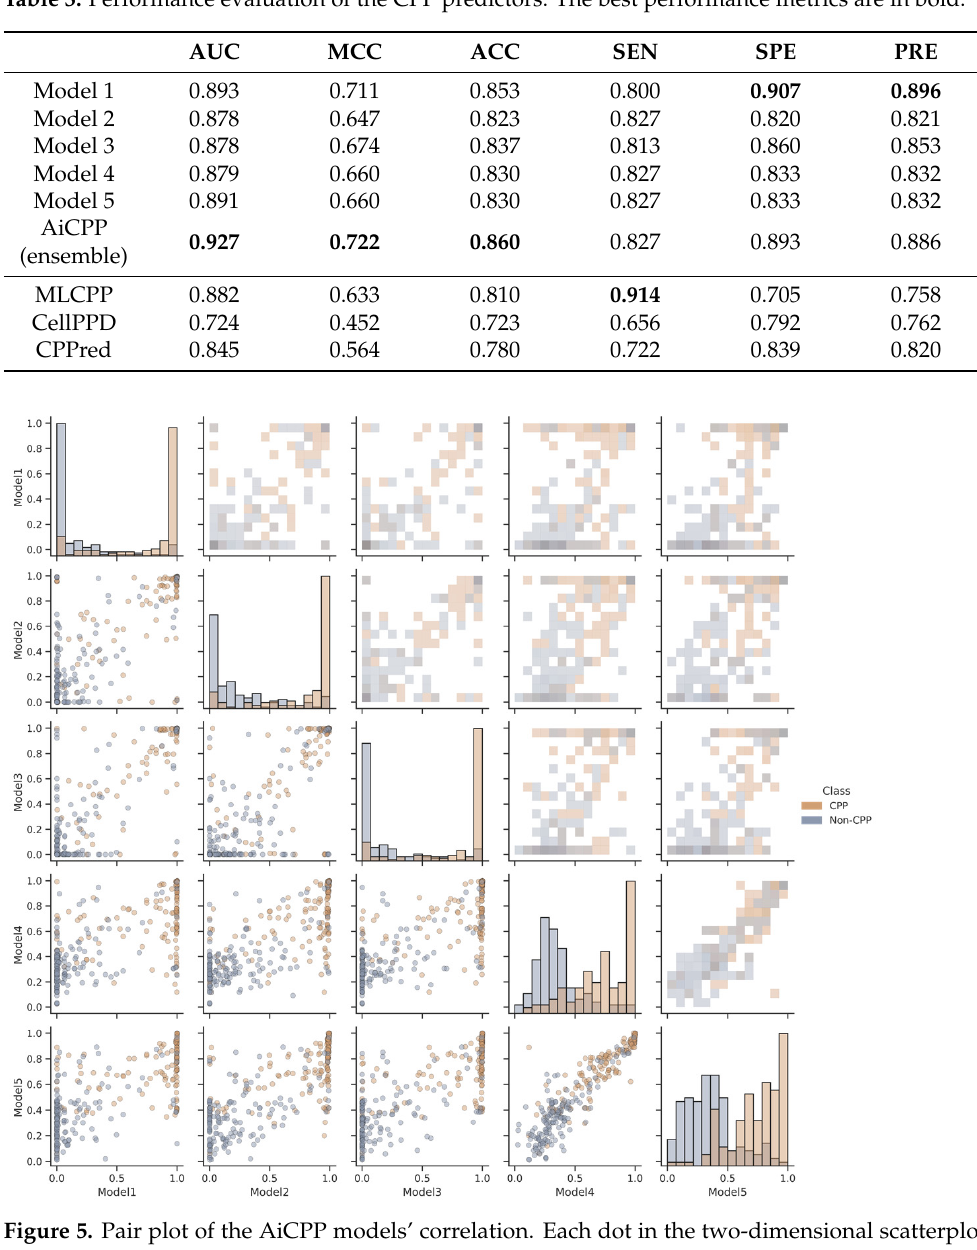
Table 3. Performance evaluation of the CPP predictors. The best performance metrics are in bold.